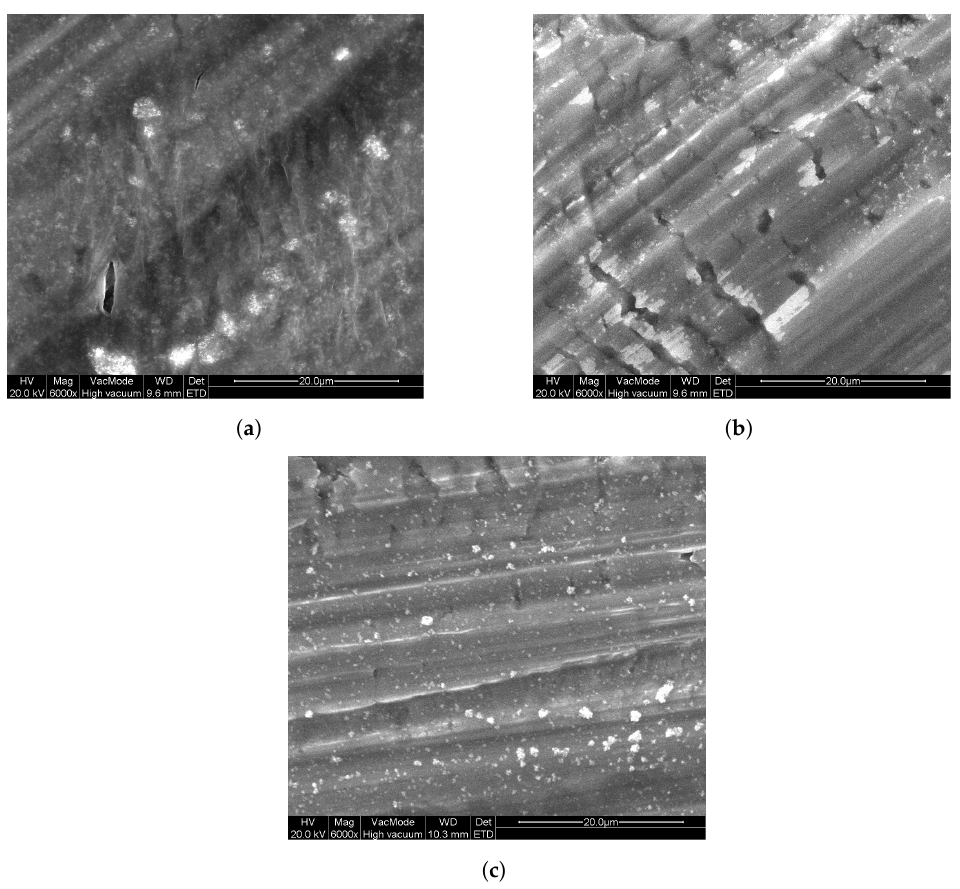
Figure 4. SEM images of the polymer/TiO 2 coatings on aluminum substrates: ( a ) PEG P25, ( b ) PVP P25, and ( c ) PMMA